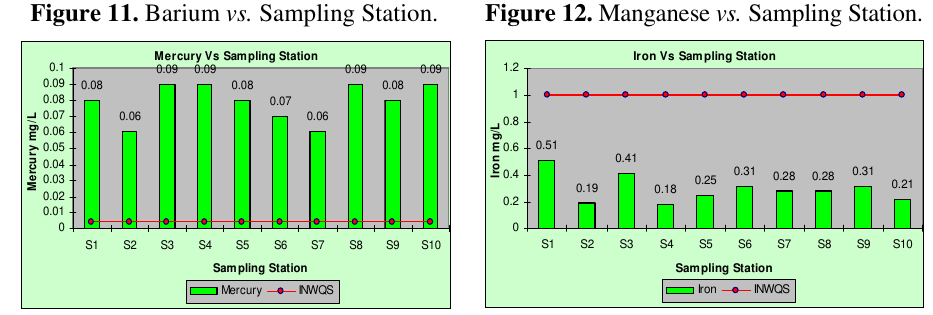
Figure 13. Mercury vs. Sampling Station. Figure 14. Iron vs. Sampling Station.